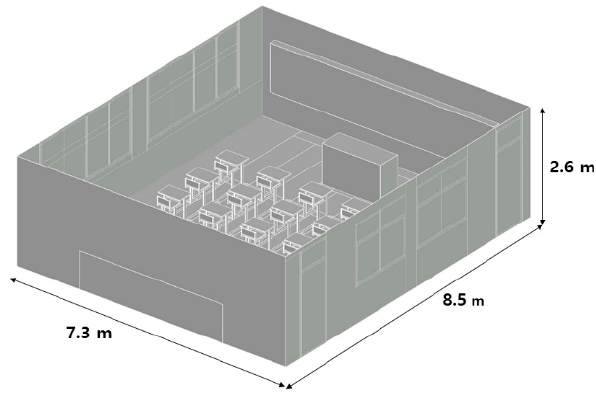
Figure 4. 3D model of standard elementary school classroom in Korea.